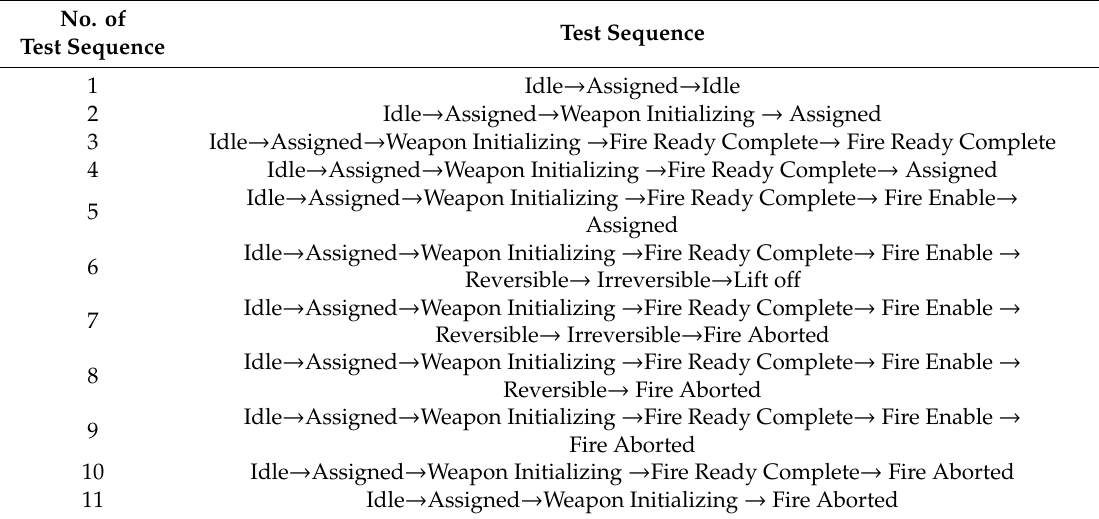
Table 5. Test suite using W method.